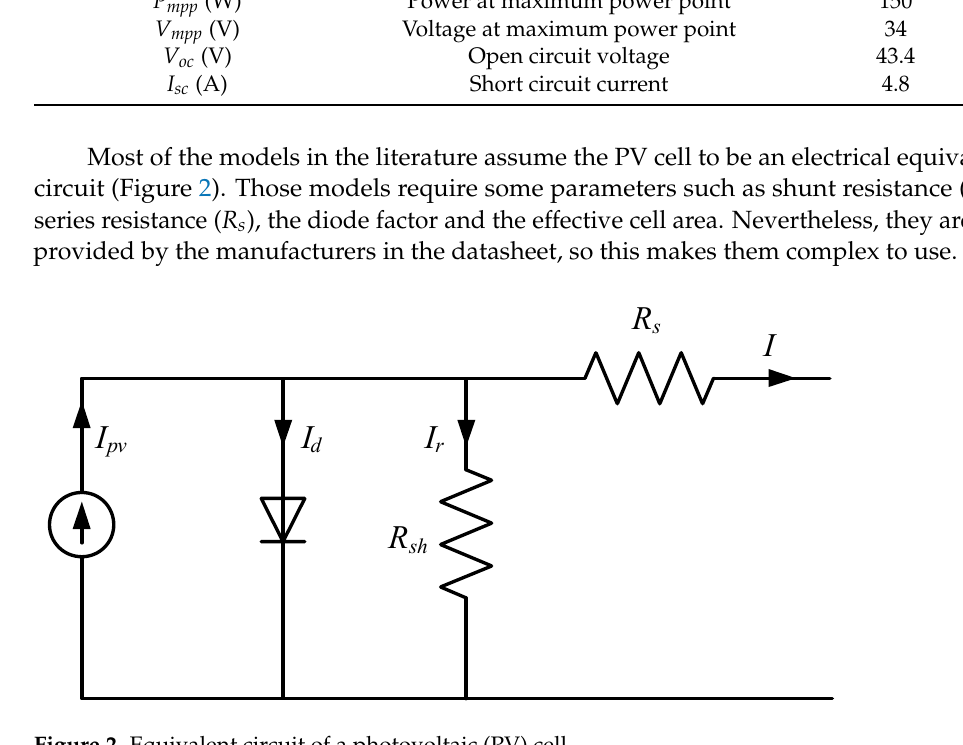
Figure 2. Equivalent circuit of a photovoltaic (PV) cell.